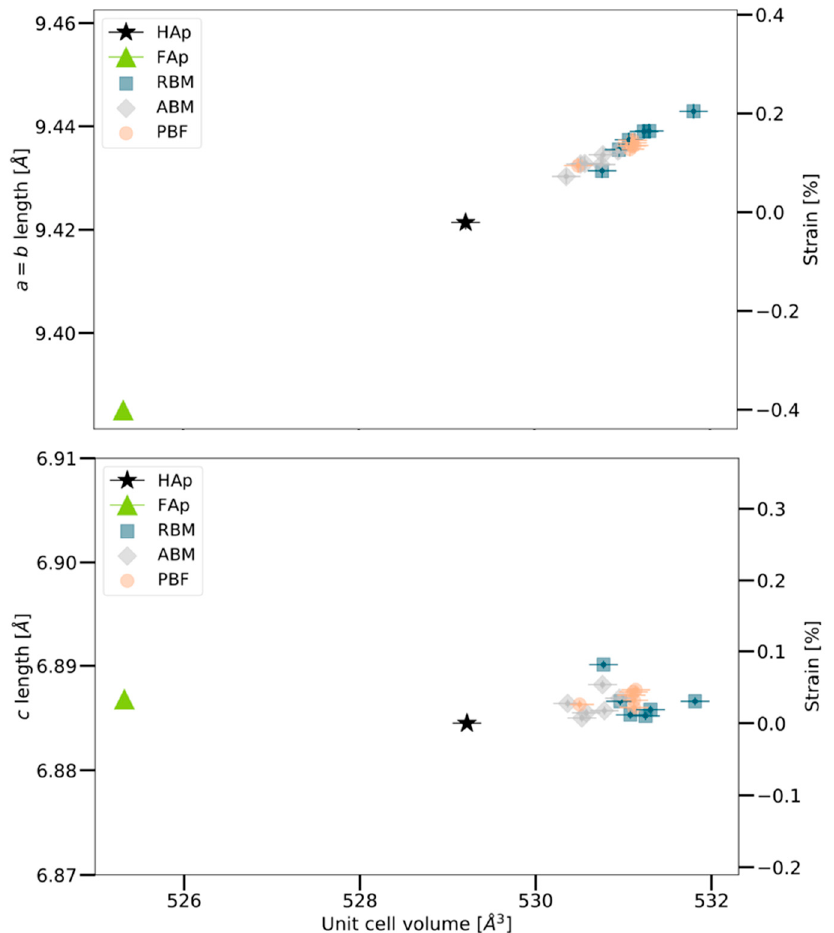
Figure 6. Unit cell lengths of human bone bioapatite determined from the Rietveld refinement of XRPD data of human bone (left axis) plotted with respect to calculated unit cell volume (bottom axis). The lengths of the lattice parameters are also expressed as strain relative to the value for hydroxylapatite (HAp) (right axis). The lengths of the lattice parameters of 2.02 wt% FAp reported by Stathopoulou et al. (2008) [21] are also plotted for comparison. RBM: Robust-build male, ABM: Average build male, PBM: Petite build female. Note that the human bone samples consistently show a much larger a (=b) lattice parameter than HAp and FAp. The reference values of hydroxylapatite unit cell lengths are taken from Greiner et al. (2019) [40]. This hydroxylapatite sample was generated from bovine bone apatite by heat treatment at 1000 °C (see Greiner et al. 2019 [40] for details). Note that even though significantly decreased unit cell lengths are observed for hydroxylapatite compared to bone apatite, its values are consistent with the trend observed for bone bioapatite unit cell lengths vs. unit cell volume in Figure 6. The unit cell volume V is trivially related to the lattice parameters as 𝑉 = 𝑎2 𝑐 sin (120°), and because of this the trends in Figure 6 may at first appear trivial. However, we observe that the a (=b) lattice parameter varies in a much wider (relative) range than the c lattice parameter , which remains relatively constant. This finding is consistent with the same trend originally realized by Stathopoulou et al. (2008) [21] and confirmed by Schmahl et al. (2017) [22] in their investigation of 63 archaeological bone samples by XRPD and Rietveld refinement. From 𝑉 = 𝑎2 𝑐 sin (120°) the expected theoretical slopes of the graphs of unit cell edge lengths versus unit cell volume ( (cid:3105)(cid:3028) (cid:3105)(cid:3023) , (cid:3105)(cid:3030) (cid:3105)(cid:3023) ) in Figure 6 can be calculated as (cid:3105)(cid:3028) (cid:3105)(cid:3023) = (cid:4670)2𝑎𝑐 sin (120°)(cid:4671) (cid:2879)(cid:2869) and (cid:3105)(cid:3030) (cid:3105)(cid:3023) = (cid:4670)𝑎2 𝑠𝑖𝑛 (120°)(cid:4671) (cid:2879)(cid:2869) . Thus, we find that for a random distribution of the lattice parameters around the observed mean values, we expect in Figure 6 a slope of 0.00889 Å − 2 for lattice parameter a (=b) and a ~25% larger slope of 0.0130 Å − 2 for lattice parameter c . Contrary to this expectation, we observed that